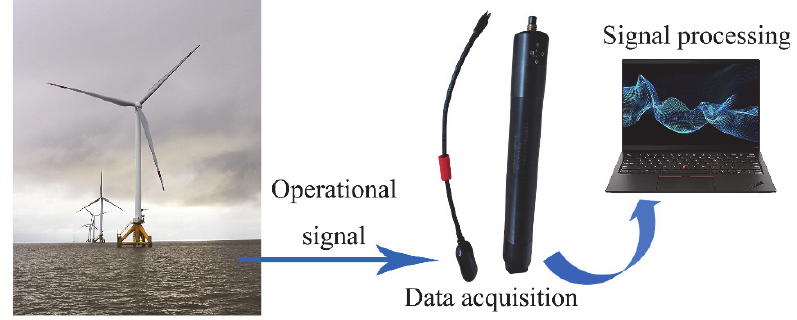
Figure 7. The measured offshore wind turbine and the data acquisition system.